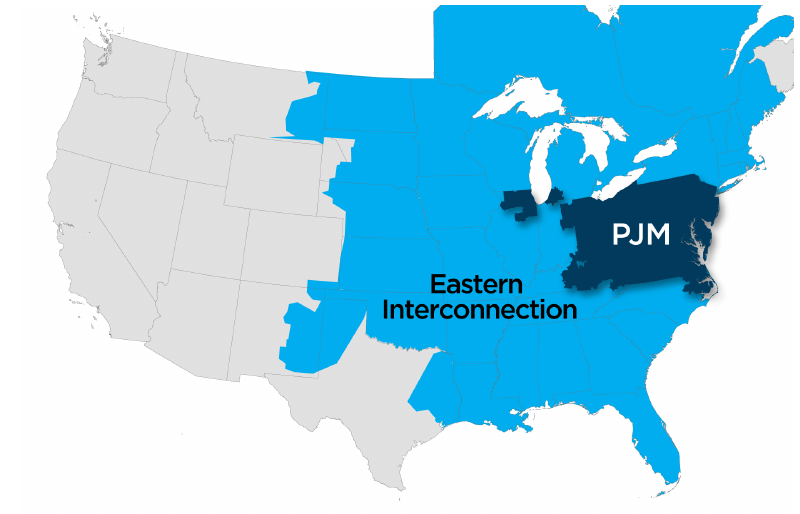
Figure 1. PJM service area. The dark blue area is the region. The light blue area is the Eastern Interconnection, which is electrically connected to PJM. The Regional Transmission Organization (RTO) is charged with balancing supply and demand over this region as well as managing imports and exports of electricity. source: